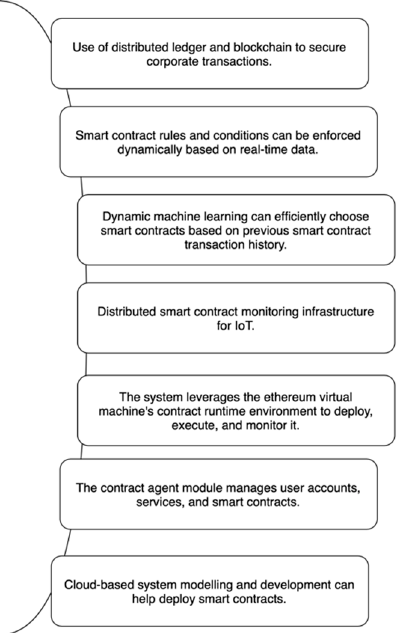
Figure 10. Key Features of Smart Contract System.